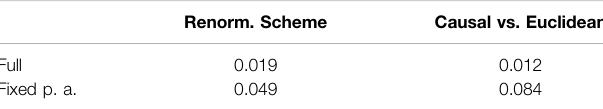
TABLE 5 | Renormalization scheme dependence and Causal-Euclidean difference with both methods. Renorm.